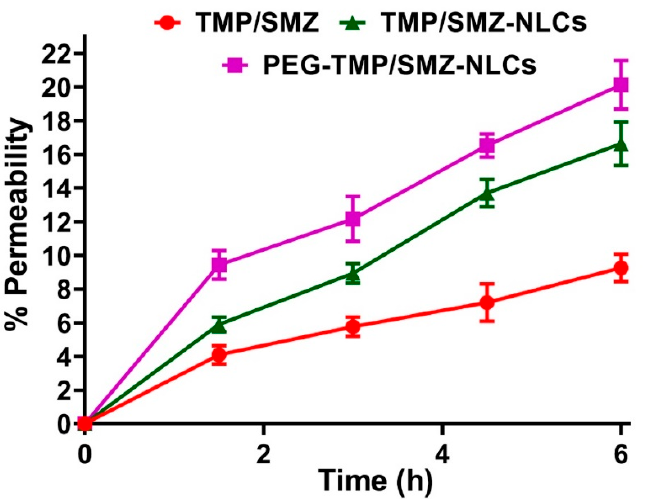
Figure 6. The TMP/SMZ transported through the Caco-2 cell monolayer quantified using UHPLC. The results were expressed as mean ± SD from 3 independent experiments (n = 3 ).